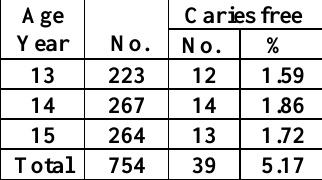
Table 3: Distribution of caries free among students by age groups.